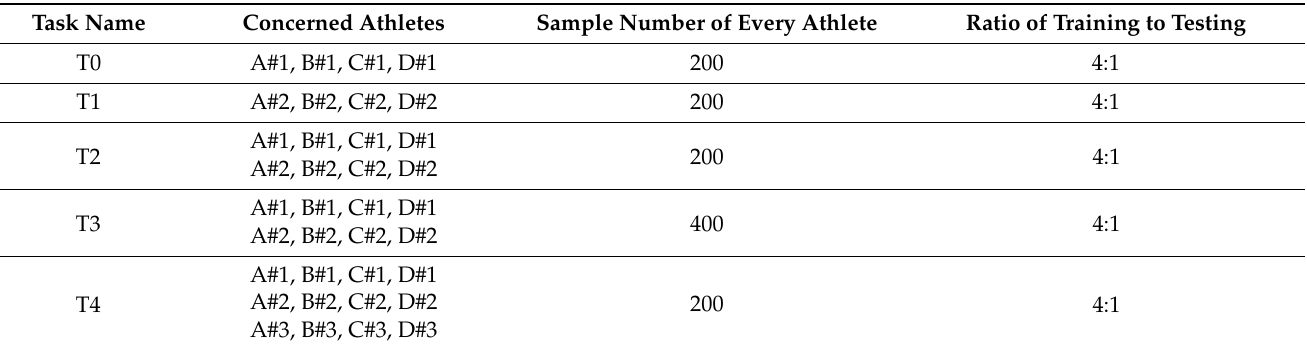
Table 2. Information for the different athlete balance control ability evaluation tasks used in this study.